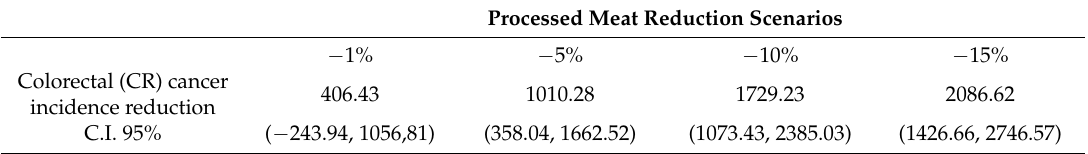
Table 3. Monte-Carlo simulation results: impact of reduced processed meat consumption on the reduction of colorectal cancer (cases).